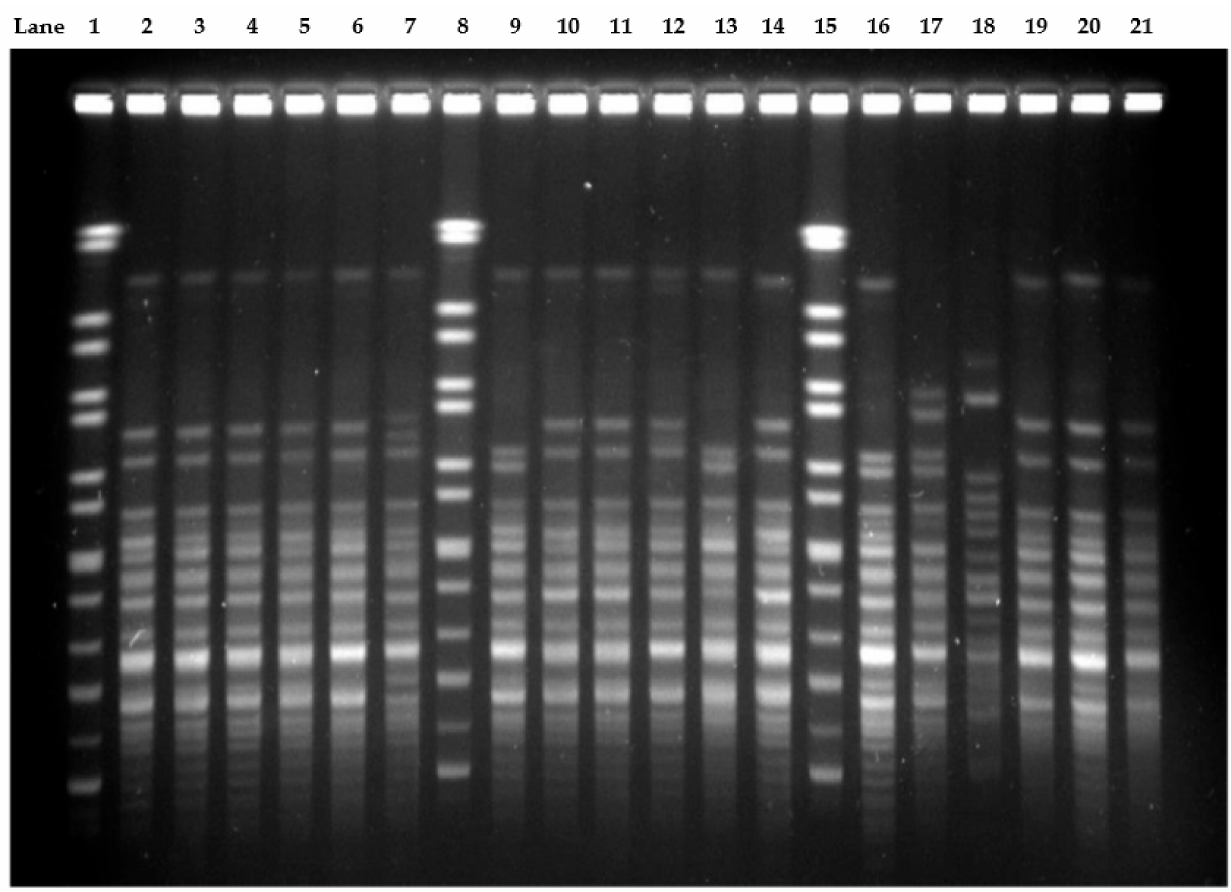
Figure 2. A representative PFGE gel image showing several CRAB pulsotypes in this study. M represents the marker used as a reference for generating the dendrogram. Lane 1, 8, 15: Marker; Lane 2: isolate 1601-5 (Ab4); Lane 3: isolate